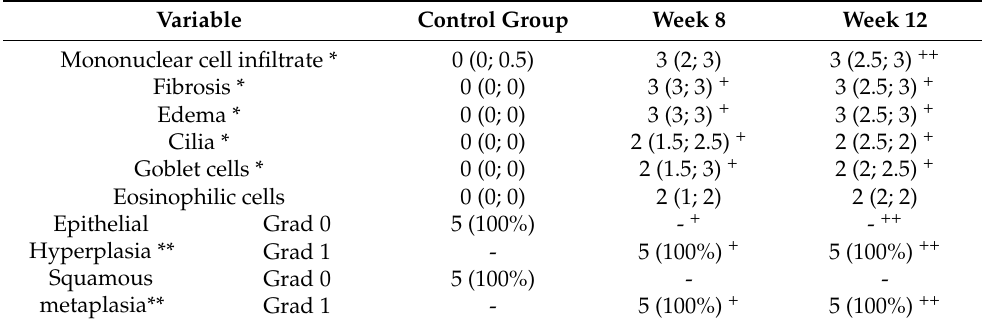
Table 3. Statistical comparison between CRS model and control